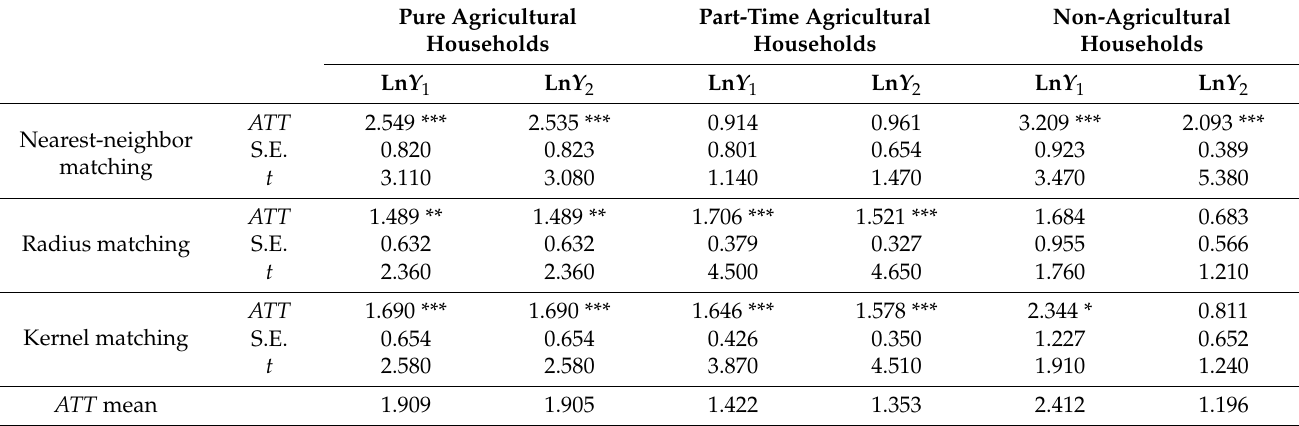
Table 11. Average treatment effect for the